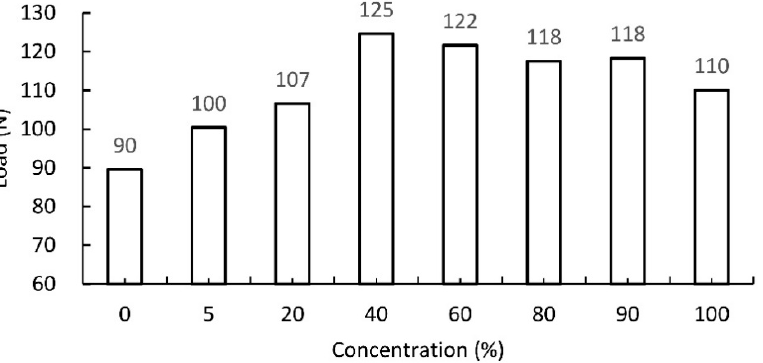
Figure 5. Tensile strength of paper impregnated with an aqueous solution of sodium silicate of varying concentration. Unimpregnated paper marked by 0% concentration.